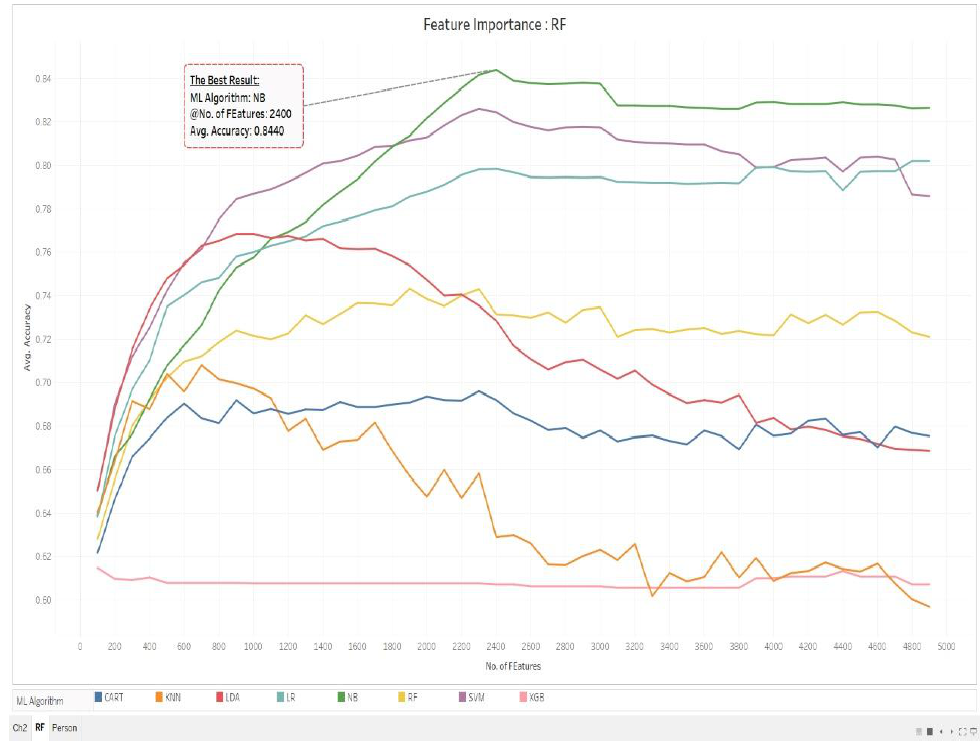
Figure 4. Accuracy of RF feature selection method with ML models .